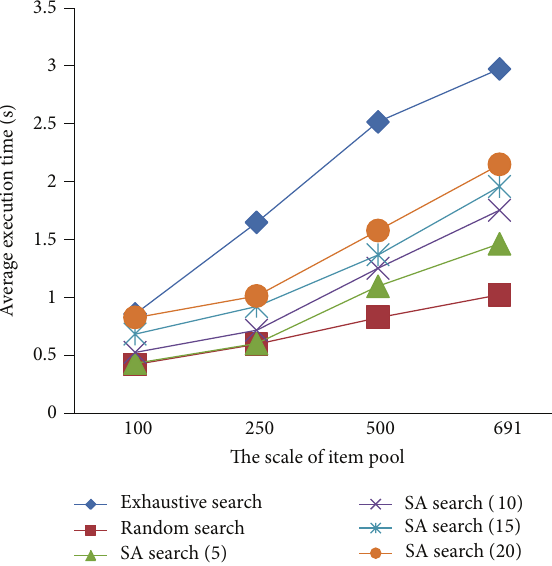
Figure 6: Algorithm execution time